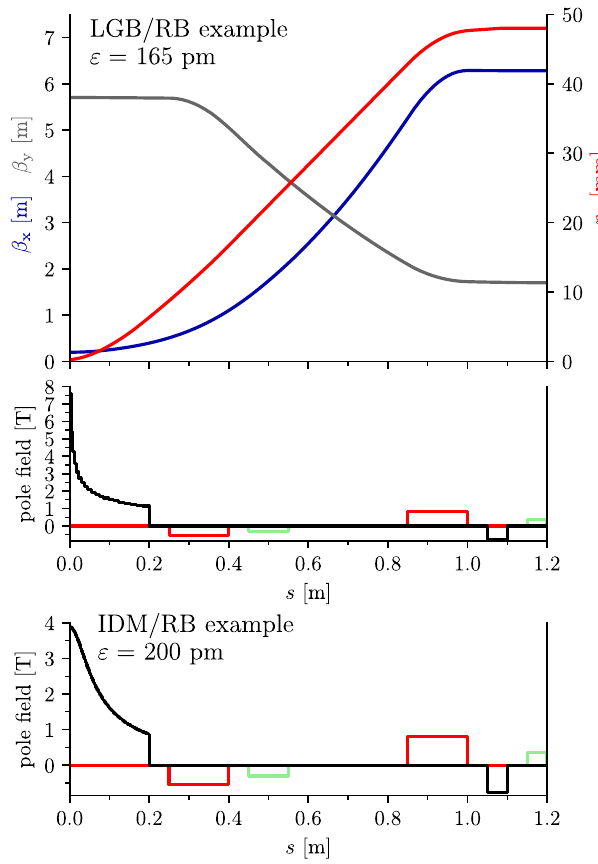
FIG. 16. Top: Field variation in a longitudinal gradient bend efficiently exploits the suppression of dispersion enabled by the reverse bend (see Fig. 4 for legend.) Bottom: Magnetic field of an LGB/RB example cell utilizing an IDM with R ¼ 2